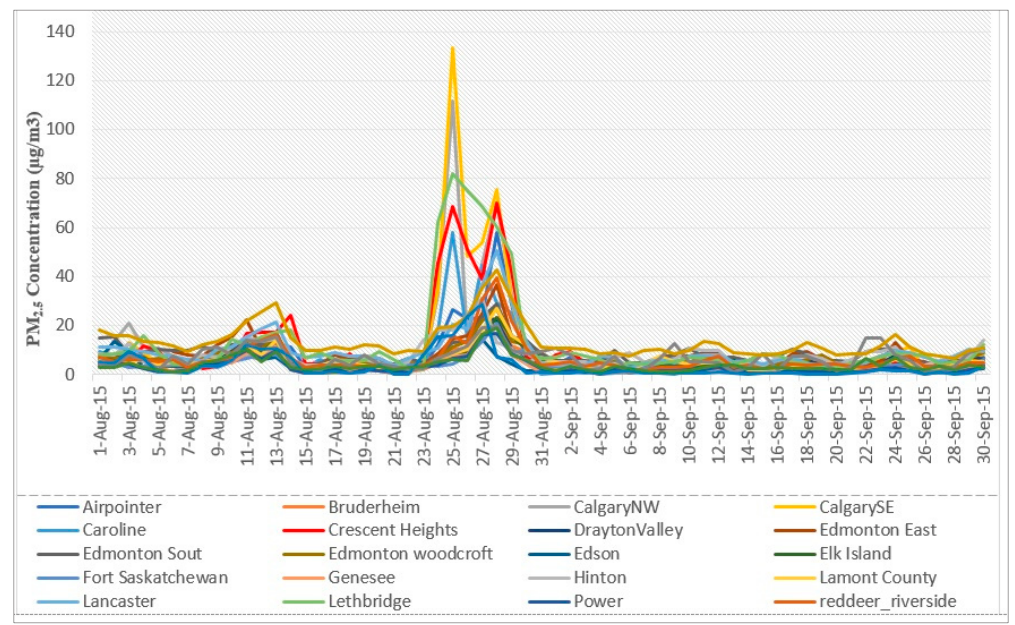
Figure 2. Temporal daily variability of PM 2.5 level at the 24 stations located at the study area.